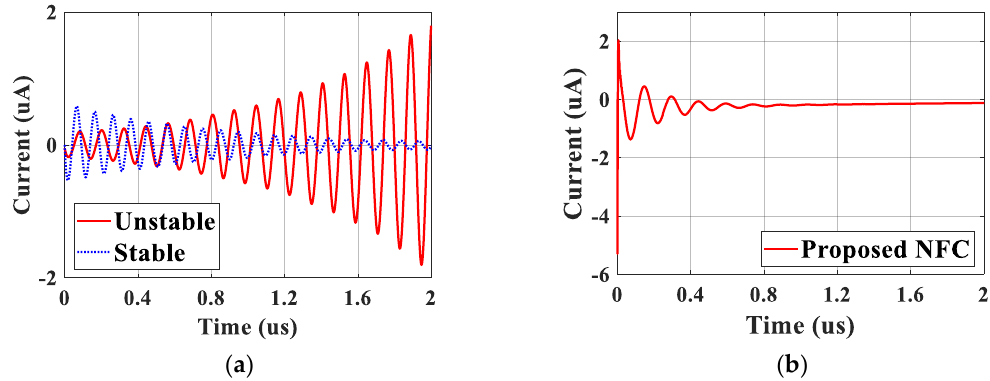
Figure 6. The transient response of non-Foster circuits: ( a ) Examples of stable and unstable transient responses; ( b ) the transient response of the proposed non-Foster circuit.